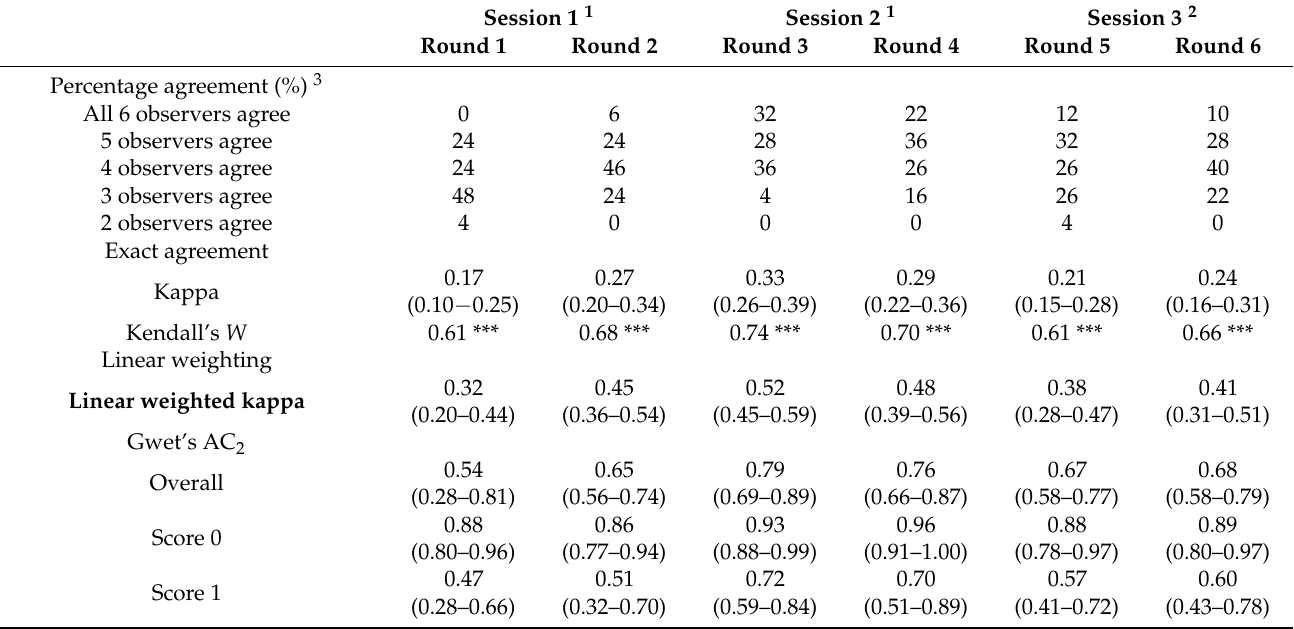
Table 2. Inter-observer reliability coefficients of white striping scoring of turkey breast muscle (0–3 scale) to assess agreement between 6 observers over multiple training sessions. The 95% confi- dence interval for kappa, linear weighted kappa, quadratic weighted kappa, and Gwet’s AC 2 are given below the coefficients in